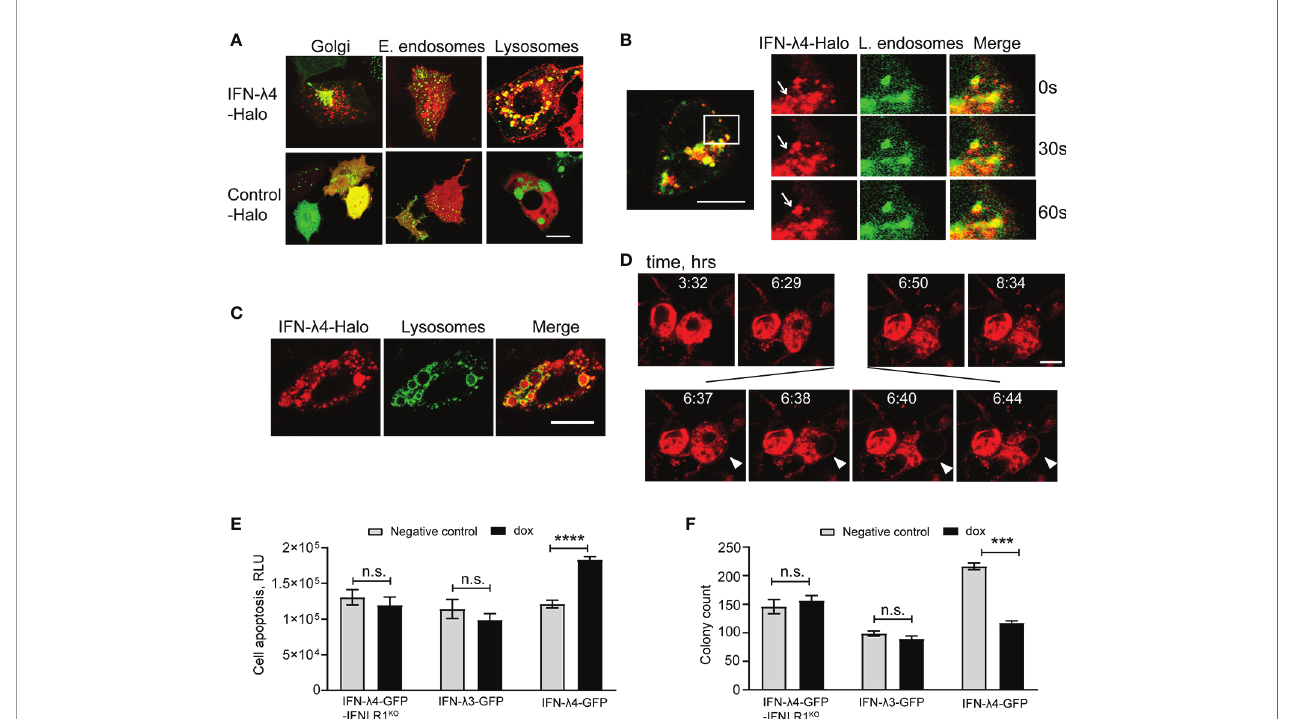
FIGURE 2 | IFN- l 4 is a misfolded protein that induces ER stress. Representative confocal images of HepG2 cells transduced with a mammalian baculovirus delivery system (BacMam) of GFP-tagged proteins targeting speci fi c organelles - lysosomes, Golgi, early and late endosomes. After transduction for 6 hrs, cells were transiently transfected with Halo-tagged constructs for IFN- l 4 or control for indicated times, stained with cell-permeant Halo-tag ligand TMR (red), and imaged. (A) Confocal images showing IFN- l 4 accumulation in lysosomes but not in early endosomes. (B) Late endosomal traf fi cking of IFN- l 4, with the inset showing larger magni fi cation. (C) Unfolded protein response (UPR) is represented by lysosomal enlargement after protein accumulation. (D) Live images of IFN- l 4-expressing HepG2 cells undergoing apoptosis, characterized by membrane blebbing and cell death. Images were scanned every minute for 12 hrs. Scale bars – 10 um. (E) Apoptosis detection with ApoTox-Glo assays in corresponding untreated and dox-induced cells for indicated time points. RLU, relative luminescence units. (F) Graph showing counts from colony formation assay for HepG2 cells expressing IFN- l 3, IFN- l 4 or IFNLR1 KO grown in 6-well plates with or without dox for 13 days. Cell colonies were stained with crystal violet and counted with ImageJ software. The graph represents the number of colonies as a percentage of initial plated counts. n.s., not signi fi cant, ***p < 0.001, ****p < 0.0001, Student ’ s